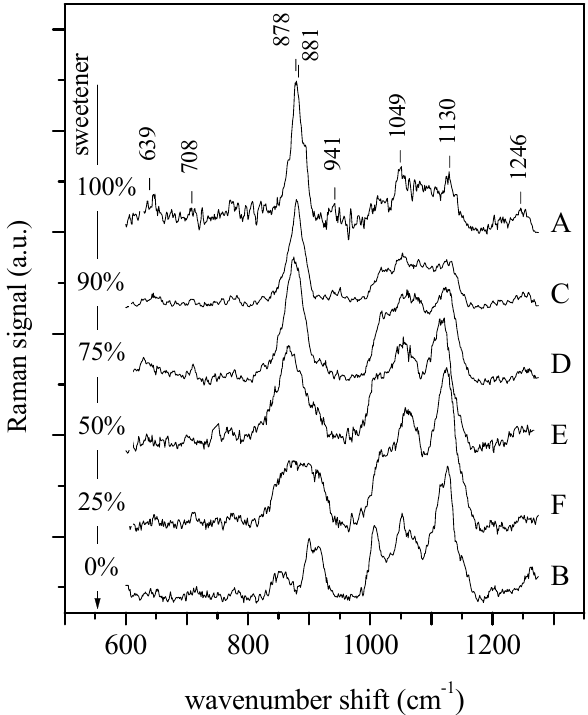
Figure 3. Raman spectra of aqueous solutions of bare sweetener (A), of glucose (B) and of sweetener/glucose mixtures with decreasing weight fraction of sweetener of 90%, 75%, 50% and 25% (C, D, E and F, respectively). The attribution of the main peaks for sample A spectrum are the following: 639 cm − 1 : fructose; 708 cm − 1 : fructose; 878 cm − 1 : mannitol and sorbitol; 881 cm − 1 : fructose; 941 cm − 1 : sorbitol and mannitol; 1,049 cm − 1 : sorbitol